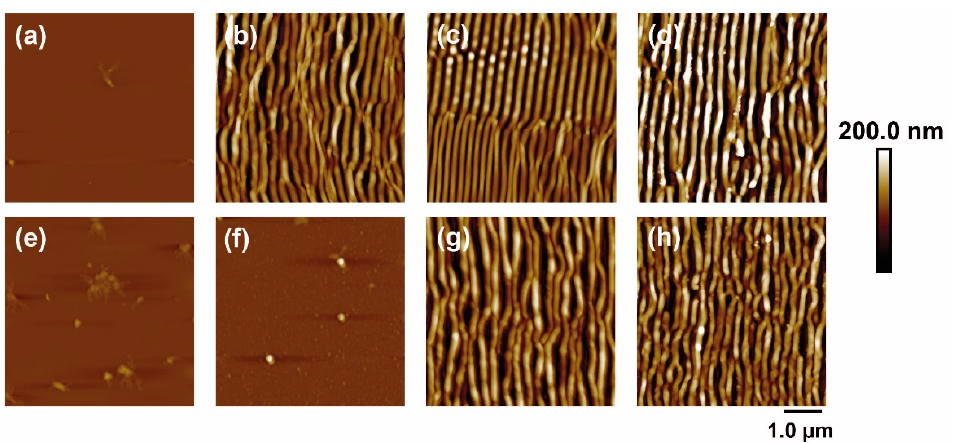
Figure 1. AFM topography images of PET ( top row ) and PET/EG 0.4 wt.% ( bottom row ) thin films: ( a , e ) before and after irradiation with ( b , f ) 11.6 mJ/cm 2 , ( c , g ) 13.8 mJ/cm 2 , and ( d , h ) 15.7 mJ/cm 2 . Laser irradiation was performed with 5000 pulses at a wavelength of 265 nm.